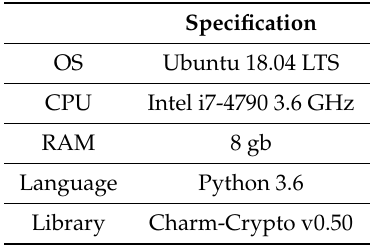
Table 2. Environment of the implementation.